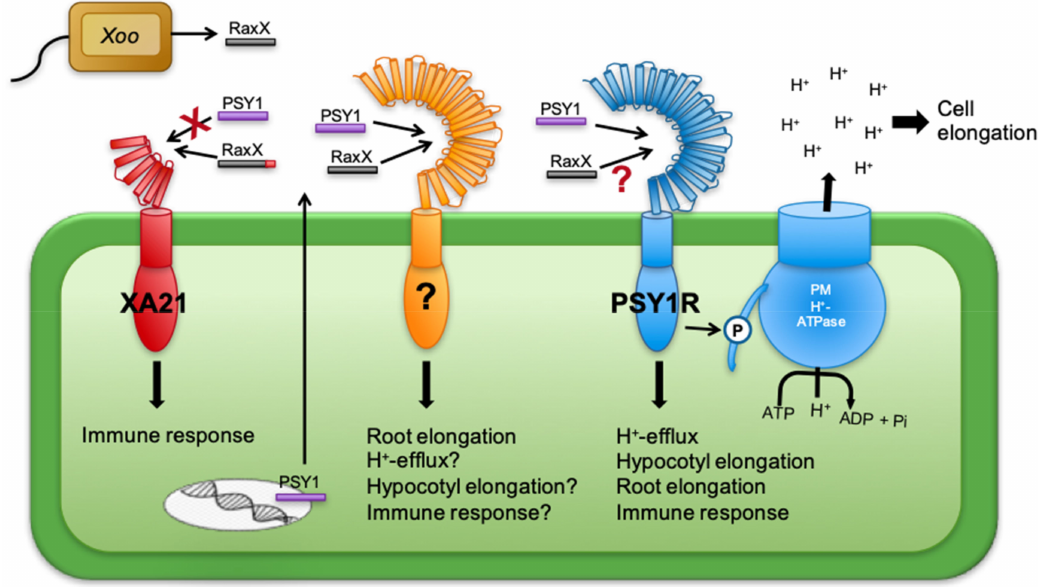
Figure 7. Model of PSY1 and RaxX signaling pathways. RaxX, a pathogenic molecule closely mimicking PSY1, is recognized by the immune receptor XA21, but only when carrying its C-terminal domain. XA21 does not bind PSY1. The PSY1 signaling pathway involves the PSY1 receptor (PSY1R) which induces hypocotyl and root elongation, immune response and H + -efflux by activating the plasma membrane (PM) H + -ATPase. PSY1 and RaxX induce root elongation using a signaling pathway not including PSY1R, suggesting an additional receptor recognizing the conserved PSY domain present in all PSY homologs as well as